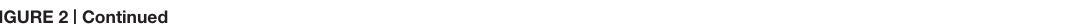
Supplementary Table 1. To normalize expression data, ubiquitin conjugating enzyme ( UBQ ), Elongation factor 1 α ( EF1 α ) and glyceraldehyde-3-phosphate dehydrogenase ( GAPDH ) were used (Monteiro et al., 2013). Transcript abundance of inoculated samples relative to mock inoculated controls at each time point is represented as the mean and standard deviation of five biological replicates. Expression between 0 and 1 represents a down-regulation. Asterisks ( ∗ ) represent significant difference ( p ≤ 0.05) between inoculated and control samples at the same time point (Mann–Whitney U test; SPSS Inc., USA, V20).